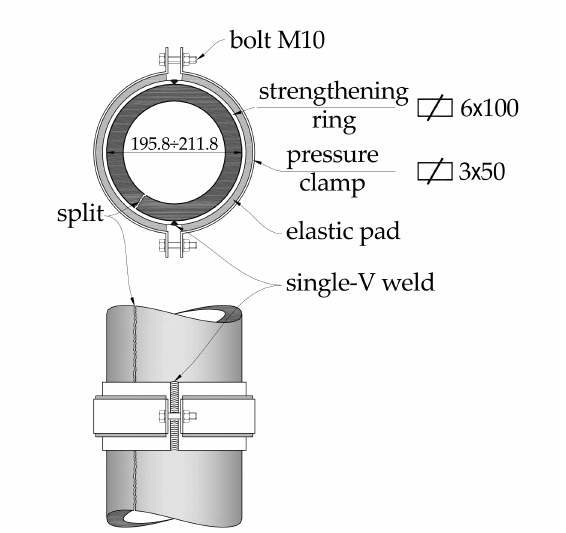
Figure 17. Detail of the strengthening of the broken cast-iron columns according to the idea of dr in˙z. J. Kozicki